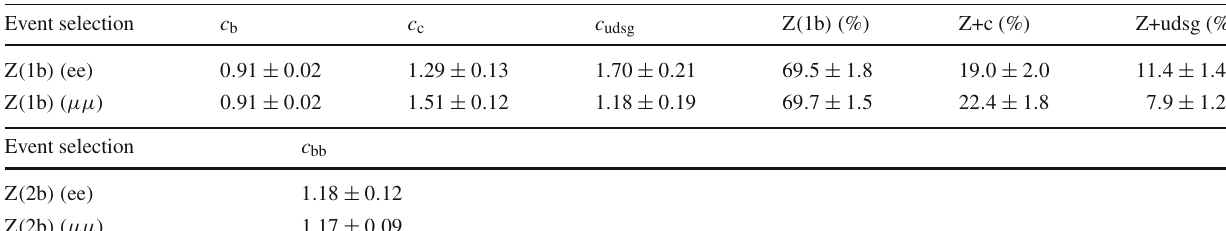
Table 1 Normalization scale factors and post-fit fractions for b, c and light-flavour (u, d, s quark and gluon) components in the selected Z ( 1b ) events, and scale factor for b in the selected Z ( 2b ) events, obtained from